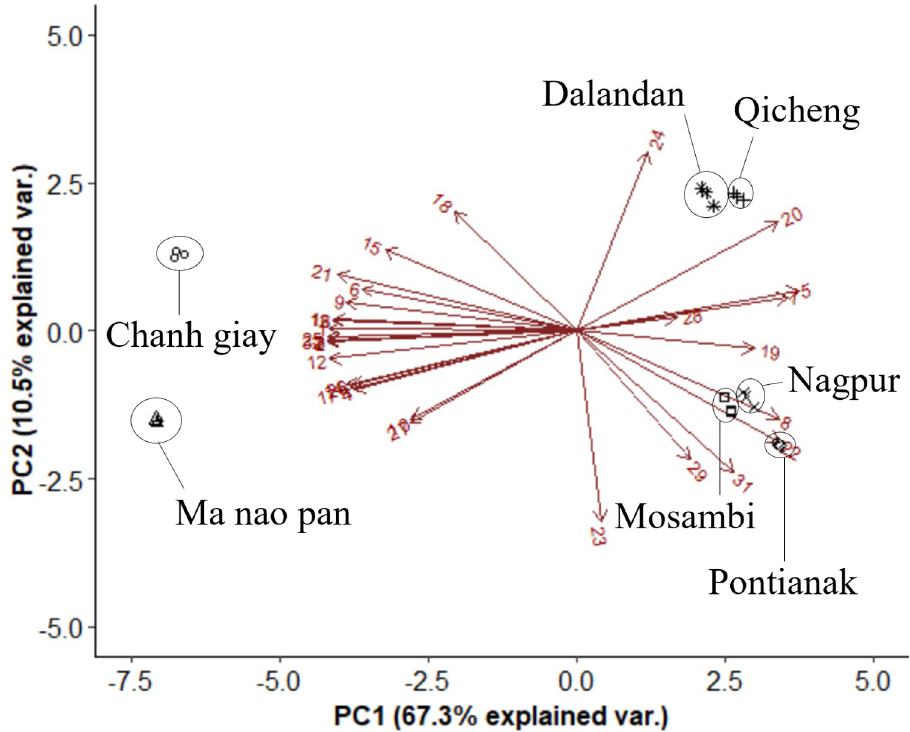
Fig 4. Biplots of identified non-volatile secondary metabolites in juice extracts of seven Asian citrus varieties. Numbers on the biplots correspond to Table 2.